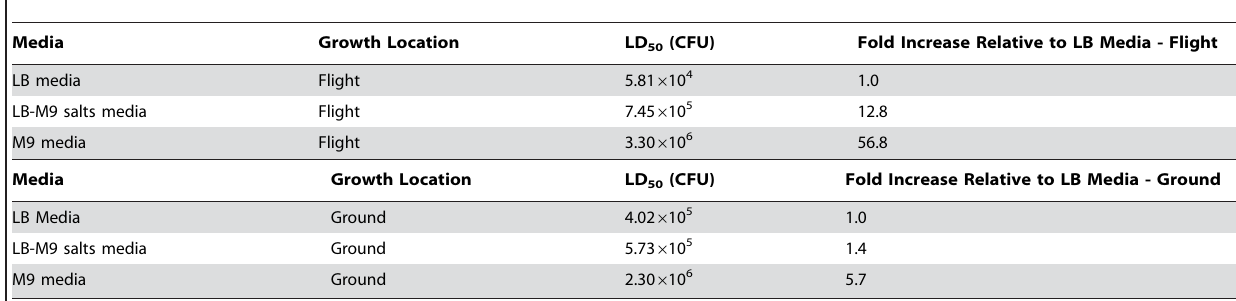
Table 1. LD 50 comparison of S. typhimurium cultured in M9 media or LB-M9 salts media relative to cultures grown only in LB